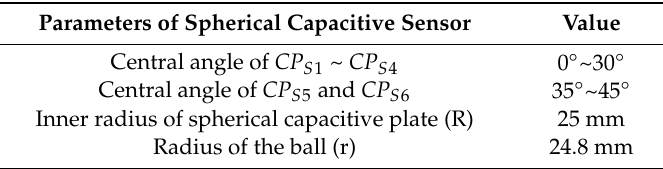
Figure 1. Geometry of the spherical capacitive sensor. Table 1. Parameters of spherical capacitive sensor.